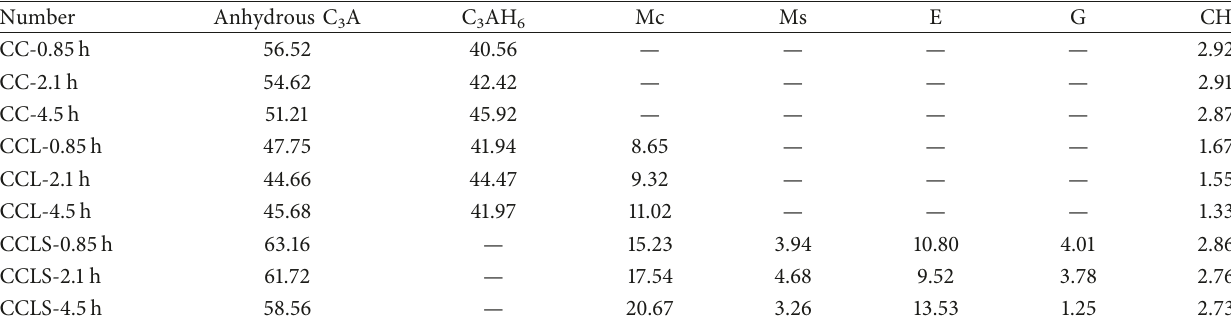
Figure 7: Heat evolution over time during cement hydration. Table 3: The content of hydration products in the pastes at various ages